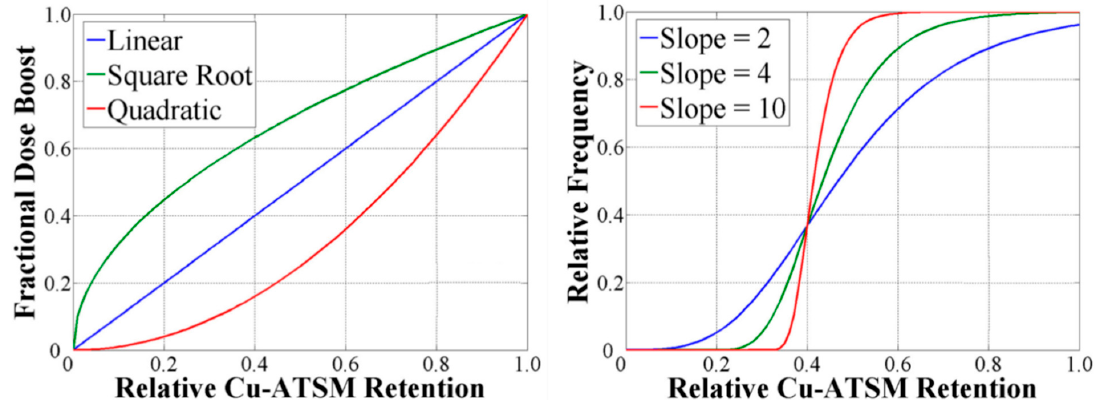
Figure 3. Quantitative forms for prescription functions. Left: Polynomial prescriptions, and right: Sigmoid prescriptions [29]. © Institute of Physics and Engineering in Medicine. Reproduced by permission of IOP Publishing. All rights reserved.